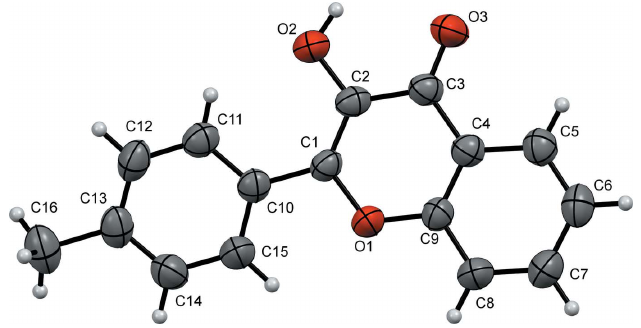
Figure 1 A view of the molecular structure of the title compound, showing the atom labeling. Displacement ellipsoids are drawn at the 50% probability level.